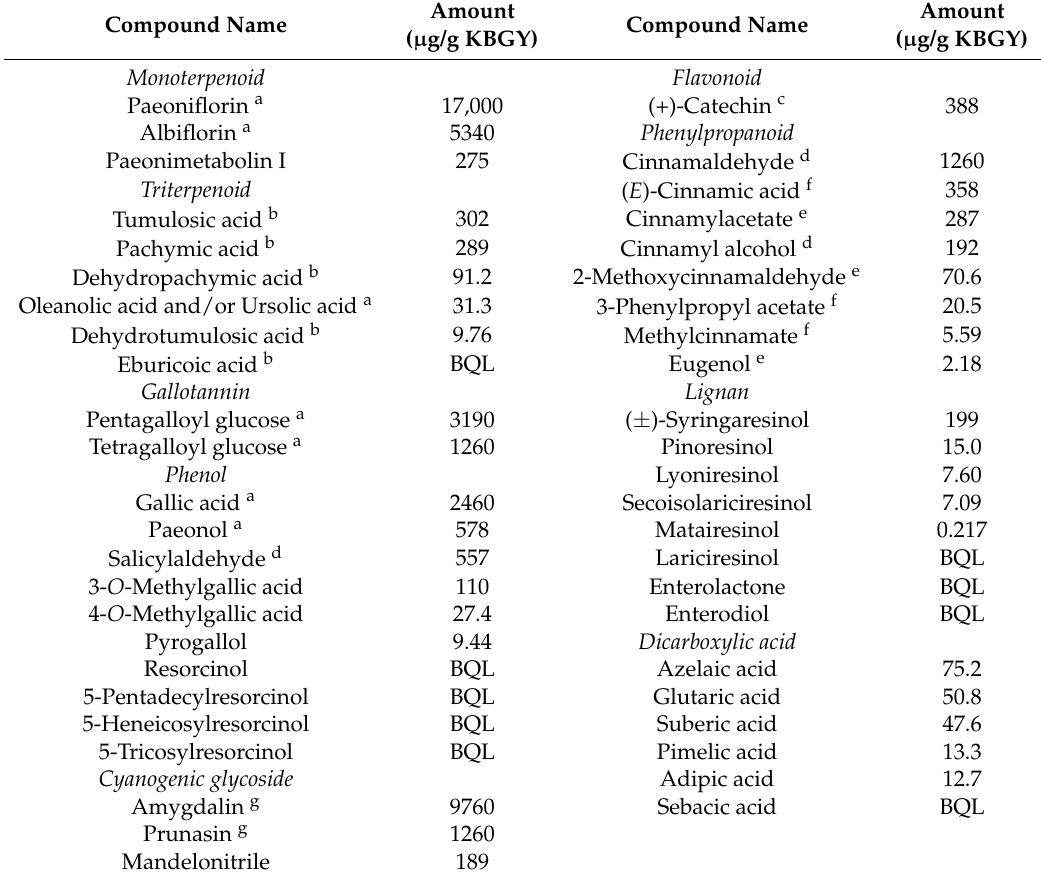
Table 1. Chemical constituents identified in KBGY